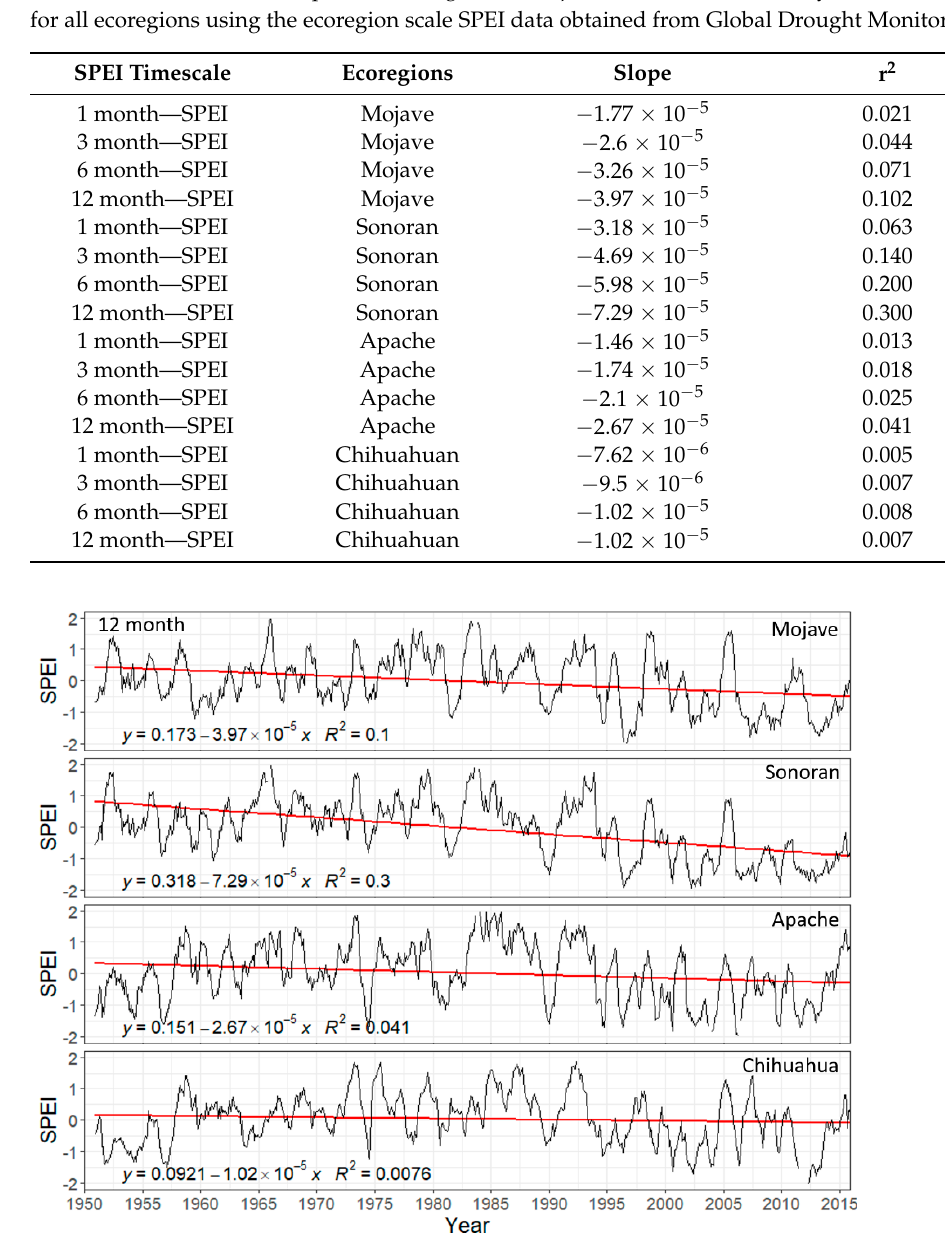
Figure 5. Time series of the spatial mean of monthly 12-month SPEI timescales for a period of 1950 January to 2015 December significant at p ≤ 0.05 for the Mojave, Sonoran, Chihuahuan deserts, and Apache Highlands. The data is obtained from Global Drought Monitor [31] and breaks in lines represent missing data.